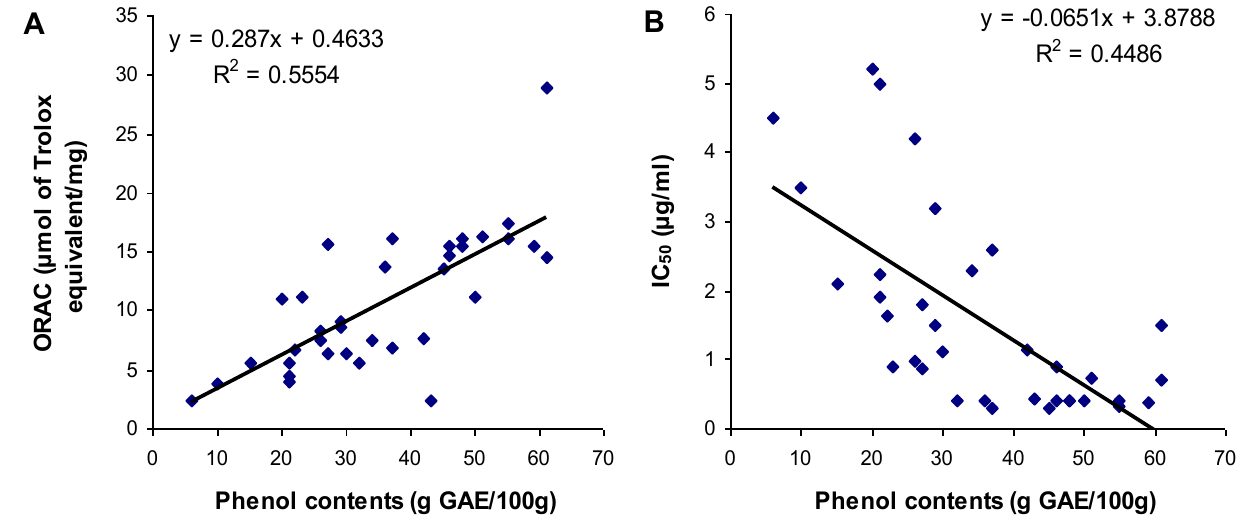
Figure 2. Relationship between ( A ) ORAC values and ( B ) IC conifer bark, and their content in phenolic compounds. Solid lines represent linear regression curves. The regression coefficient ( R 2 ) and the equation of curves are given. y = 0.287x +